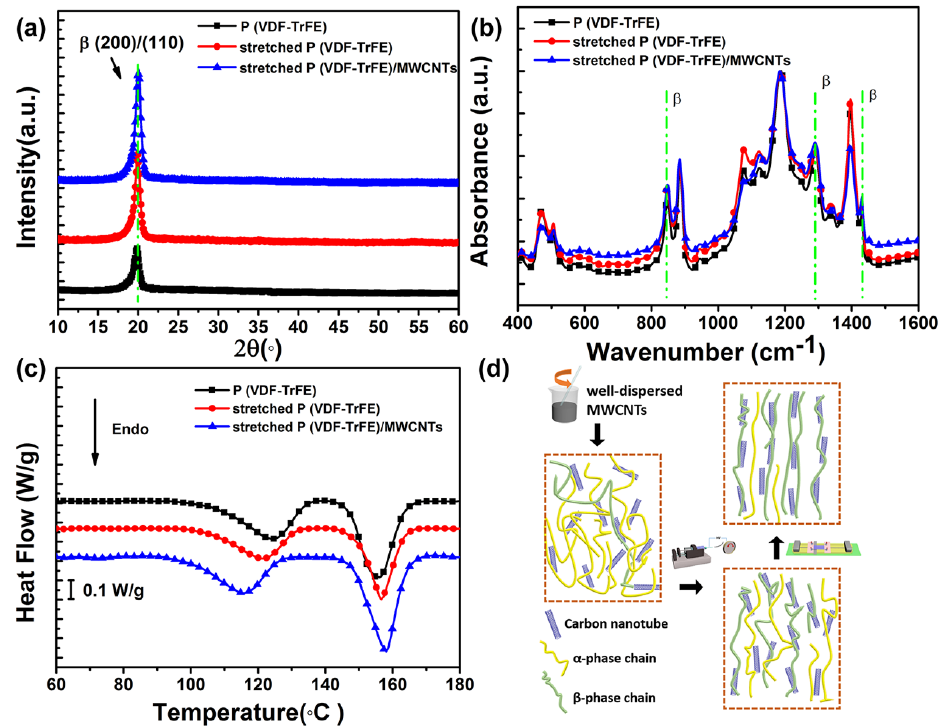
Figure 2. The crystalline and thermal characterization of P(VDF-TrFE)/MWCNT composites membranes. ( a ) XRD patterns of different prepared samples. ( b ) FTIR spectra. ( c ) DSC curves. ( d ) Schematic of